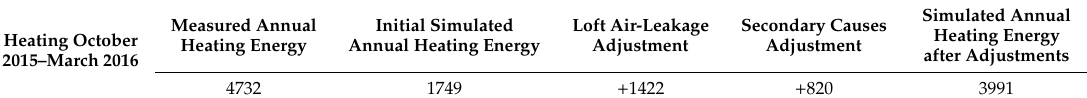
Table 5. A summary of the heating performance adjustment for the simulation accounting for the performance gap (kWh).